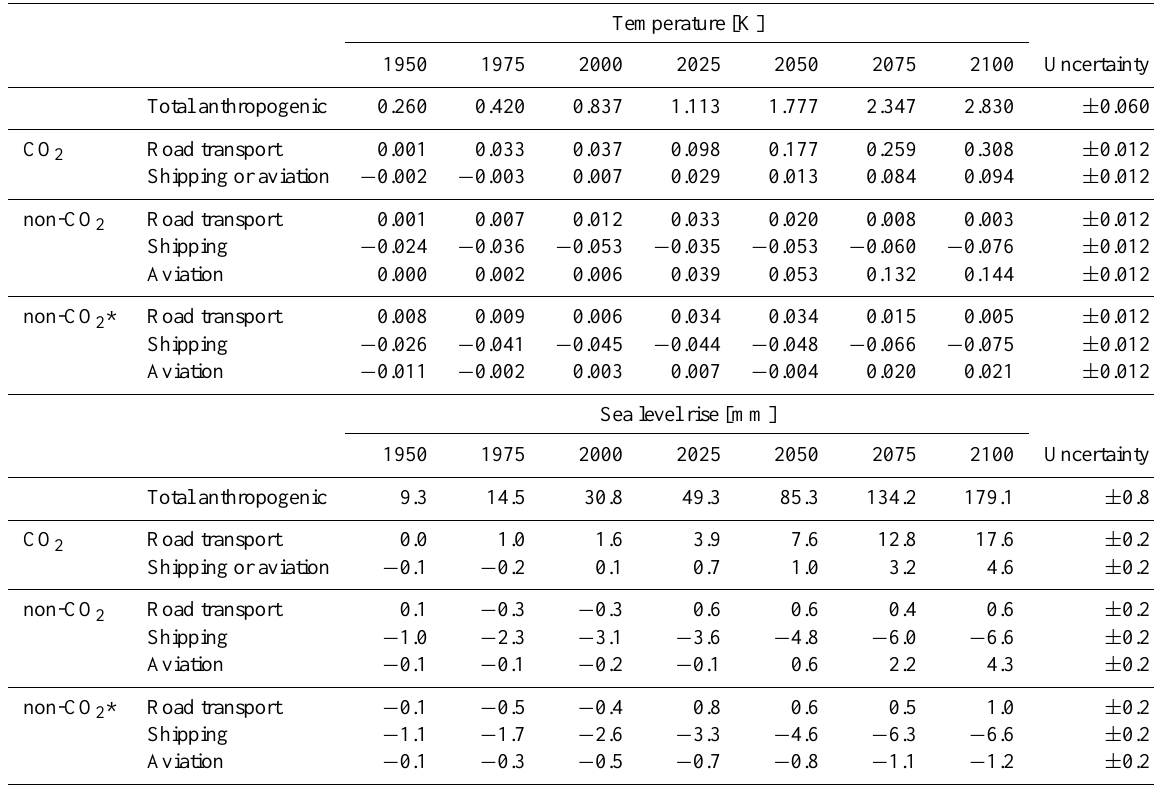
Table 5. Global mean surface air temperature change and sea level rise for selected years. The values are 11-yr means around the year mentioned, and averaged over the different members of the ensemble. The non-CO 2 * forcing is as the non-CO 2 forcing except for O 3 where prescribed O 3 perturbation fields are used (see Sects. 2.2.4 and